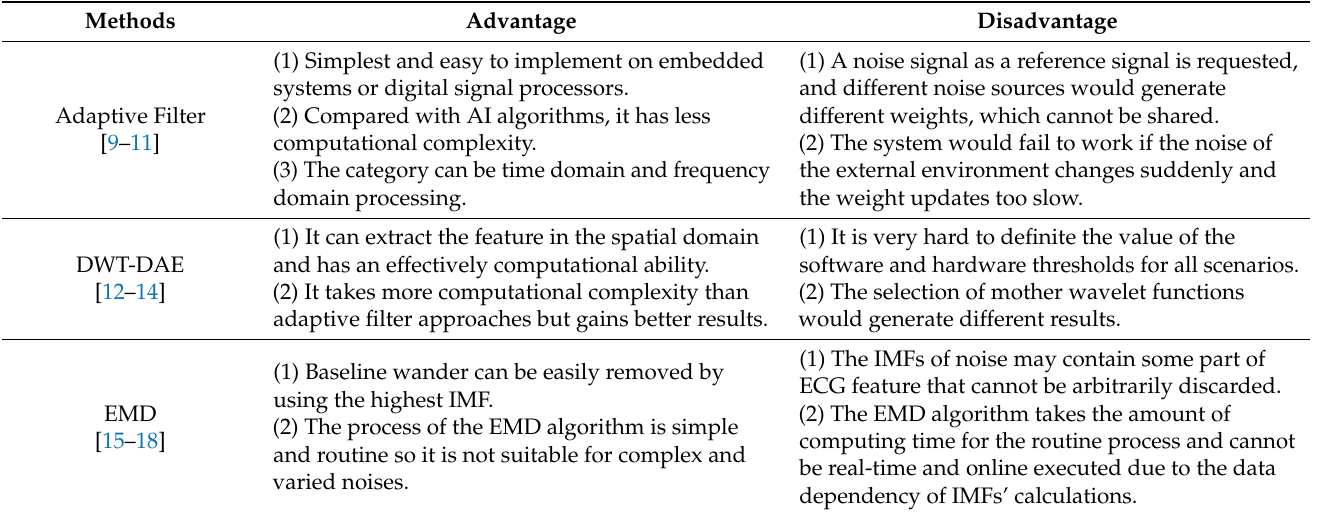
Table 1. Comparison of Advantages and Disadvantages of Various